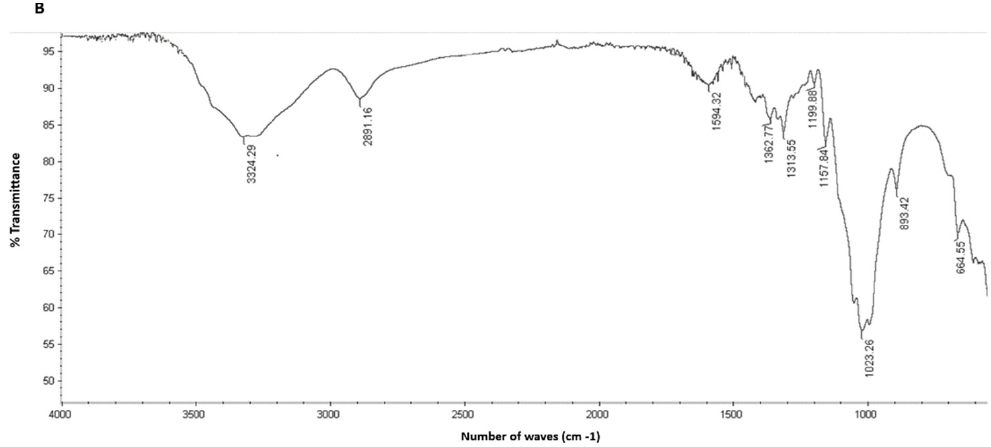
Figure 5. FTIR spectrum of the control ( A ) and functionalized ( B ) fabric with AgNPs-CMC nanocomposite.